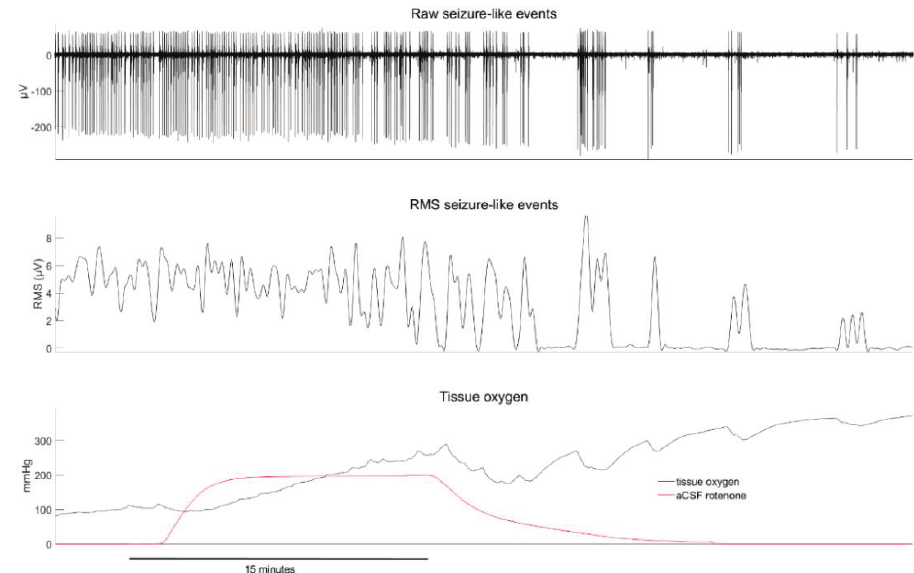
Figure 1. Example of rotenone-induced changes in seizure-like event activity (top), root mean square (RMS) seizure-like activity (middle) and tissue oxygen (bottom). The red line in the bottom figure shows the estimated concentration time course of rotenone in the perfusion bath (normalized to its maximum value and × 200 for visual scaling). Note that the tissue oxygen levels fluctuate with the intensity of neuronal activity. This is particularly evident in the second haft of the recording where bursting activity is punctuated by long silent periods.